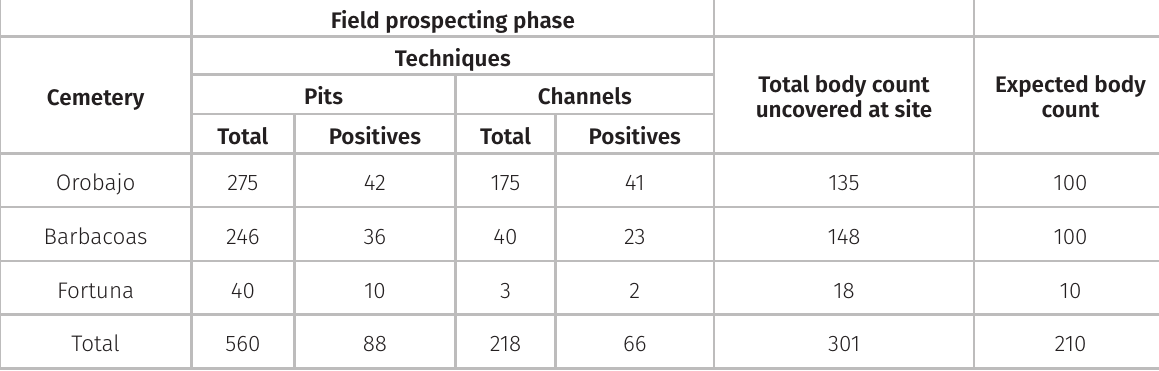
Table III. Locations of ossified remains (data collected through pedological